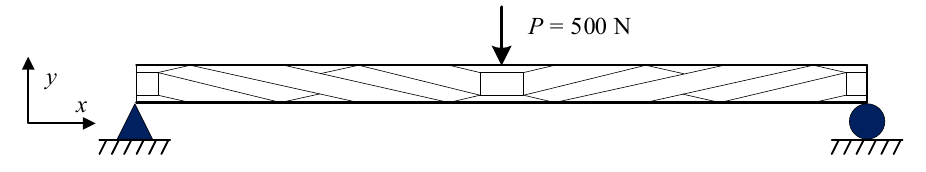
Figure 5. Three-point bending test diagram of the RVE.